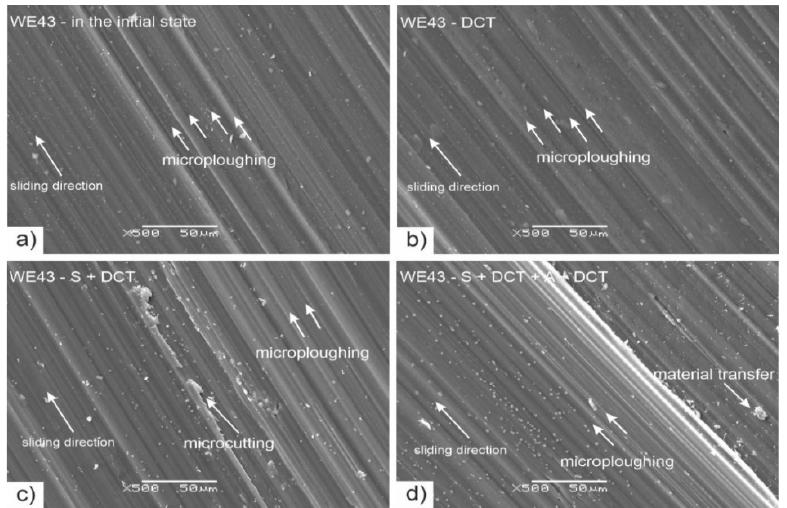
Figure 12. SEM images of the wear traces formed in rotary motion of as-delivered WE43 alloy—( a ); after deep cryogenic treatment—( b ); after solution treatment combined with DCT—( c ) and after sub-zero treatment combined with precipitation hardening—( d ).